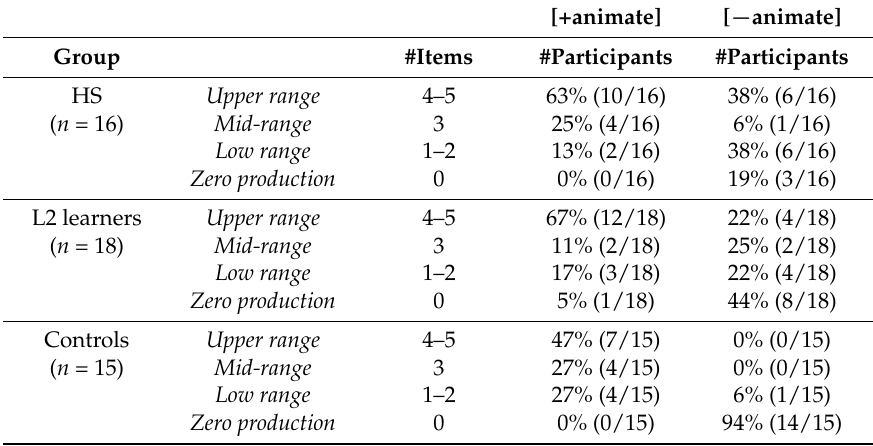
Table 3. EPT: proportion of overt DOM use in CLLD